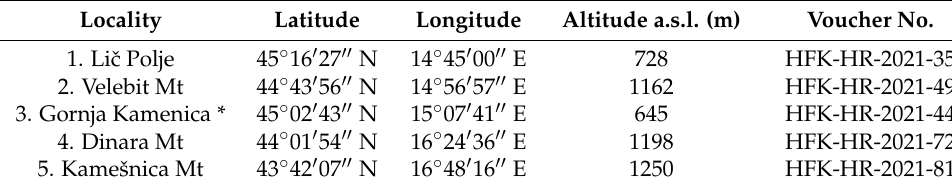
Table 1. Locations of plant material of Barrelier’s Speedwell collection. Locality Latitude Longitude Altitude a.s.l.